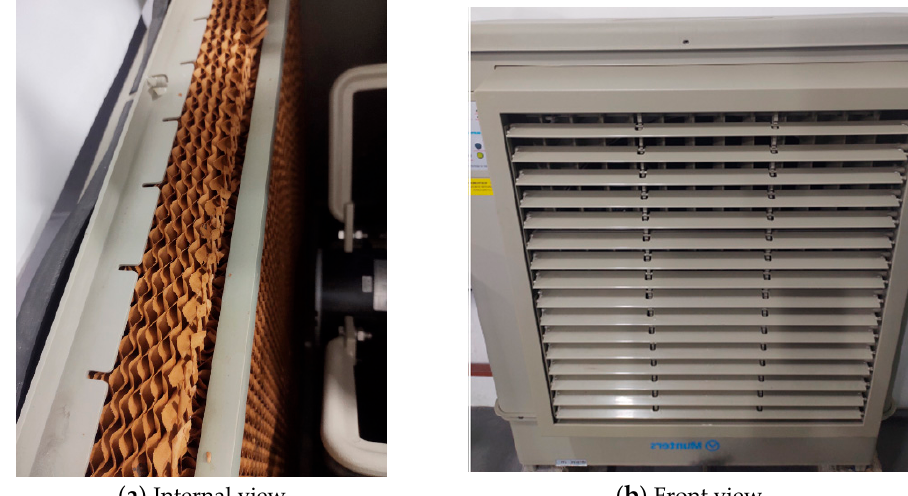
Figure 3. Munters FCA 5–20 evaporative equipment.